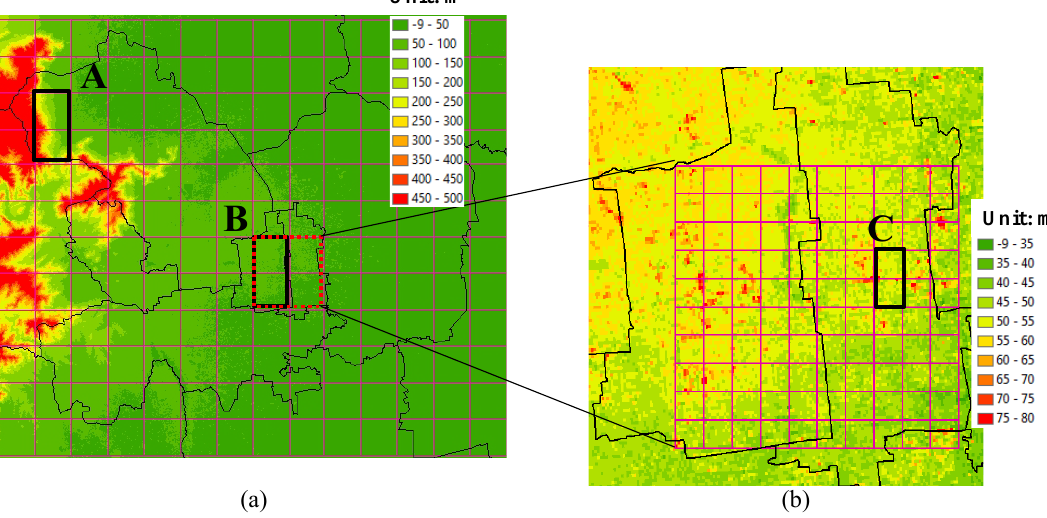
Figure 1. Modeling domains used in 3-D radiative transfer calculation: (a) Domain 1 covering urban and suburban Beijing at a grid resolution of 4km; (b) Domain 2 covering the urban center of Beijing at a grid resolution of 800m. The colors represent altitudes at a resolution of 3arcsec (about 90m) derived from SRTM. The black thin lines represent boundaries of districts. The three black bold rectangles (defined as A, B, and C, respectively) represent typical grids used to analyze diurnal variation and to quantify the contribution of flux components. The red dashed rectangle represents grids in Domain 1 that correspond to Domain